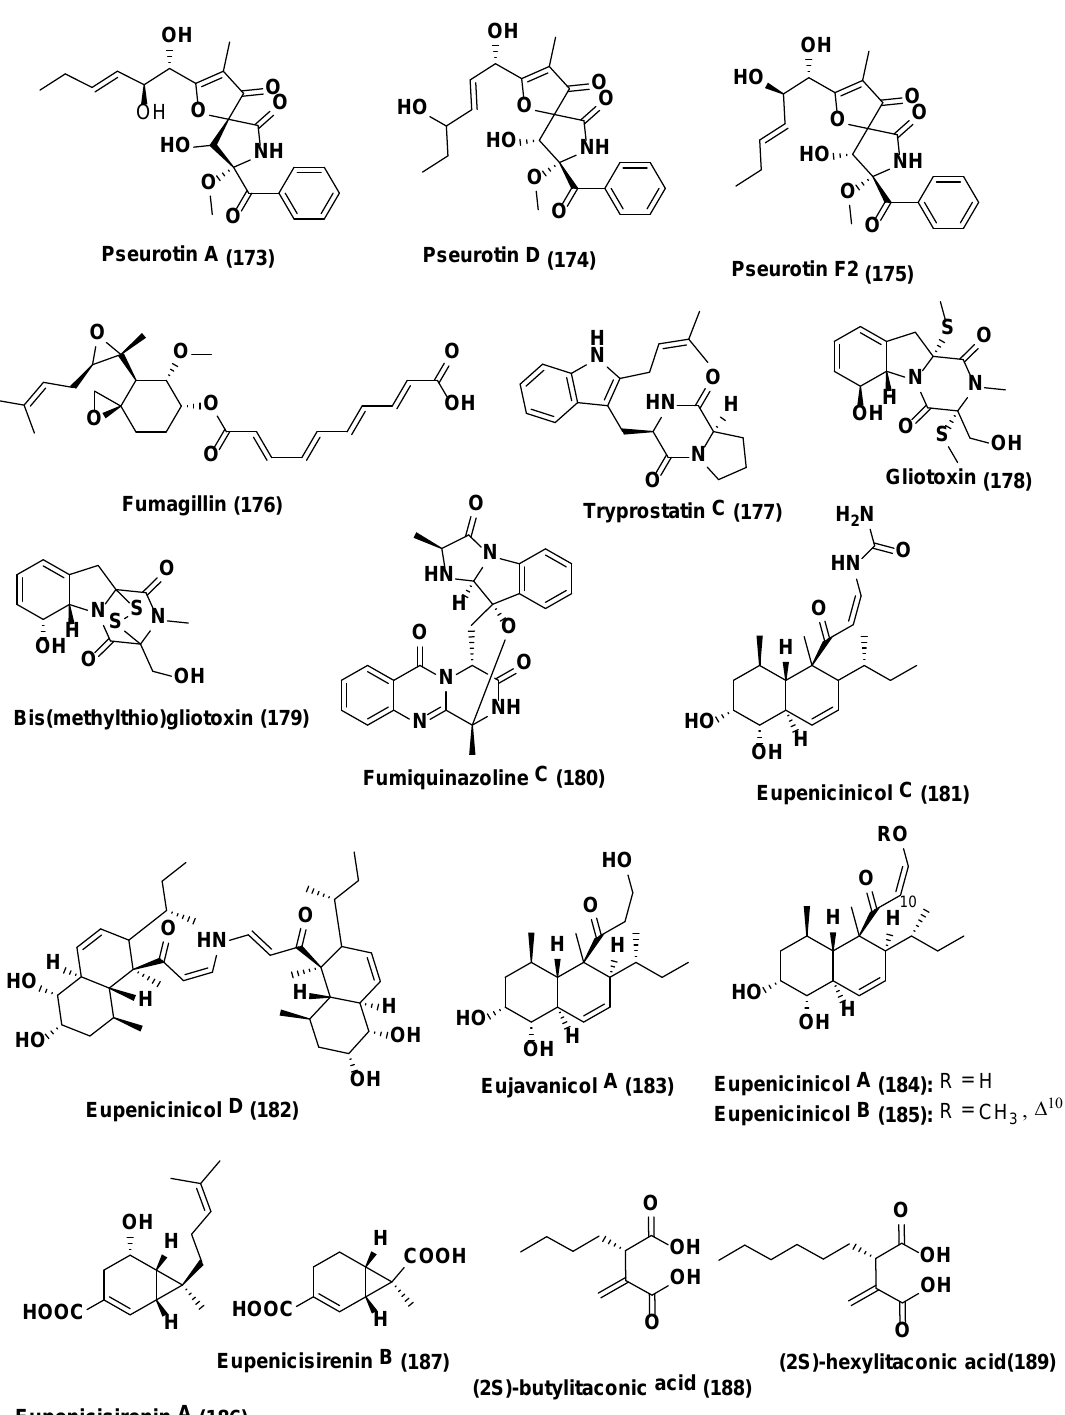
Figure 9. Structures of metabolites isolated from Epigenetic modification in endophytic fungi ( 173 – 189 ). The NAD+-dependent HDAC inhibitor, nicotinamide, enhanced the yield of eupenicinicol C ( 181 ), and D ( 182 ) (Figure 9), decalin containing metabolites together with eujavanicol A ( 183 ), and eupenicinicol A ( 184 ) (Figure 9), biosynthetically related compounds by endophytic Eupenicillium sp. LG41, identified from the Xanthium sibiricum , a Chinese medicinal plant [119]. Under a similar condition without HDAC inhibitor, nicotinamide Eupenicillium sp. LG41 produce different decalin- containing compounds: eupenicinicols A ( 184 ), and B ( 185 ); two new sirenin derivatives, eupenicisirenins A ( 186 ) and B ( 187 ); and other four known compounds, (2S)-butylitaconic acid ( 188 ),